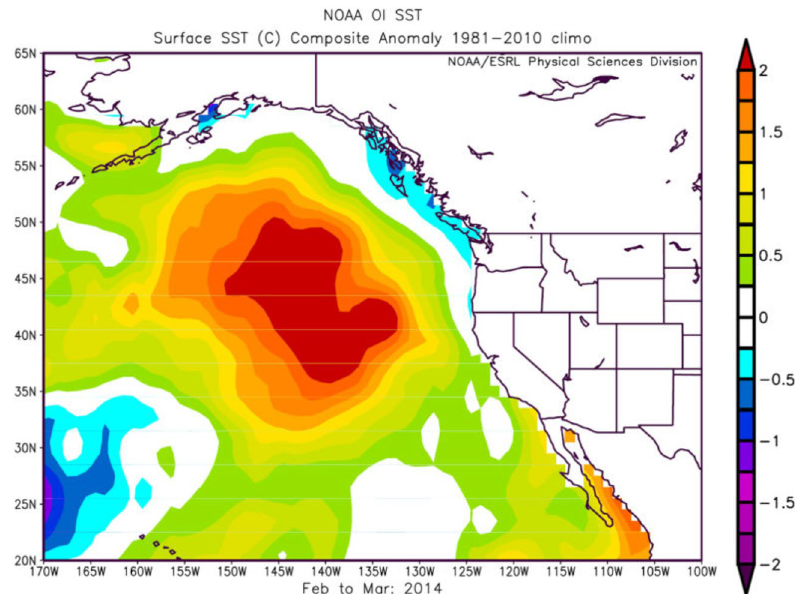
Fig. 8 Sea surface temperature (SST) anomalies’ differences from normal for February to March 2014. Source Mass